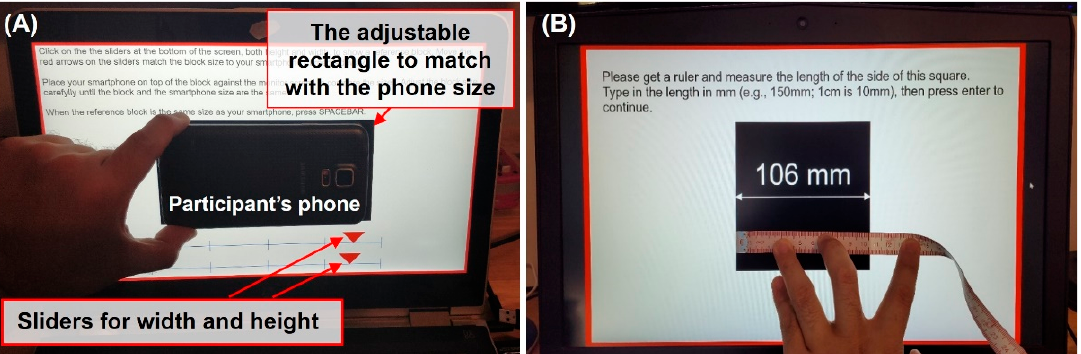
Figure 3. ( A ) Example photo of the phone size setting stage at the start of the experiment. The width ( W phone ) and the height ( H phone ) of the phones were recorded as a fraction of the height of the screen. ( B ) Example photo of the reference length ( H reference ) setting stage.